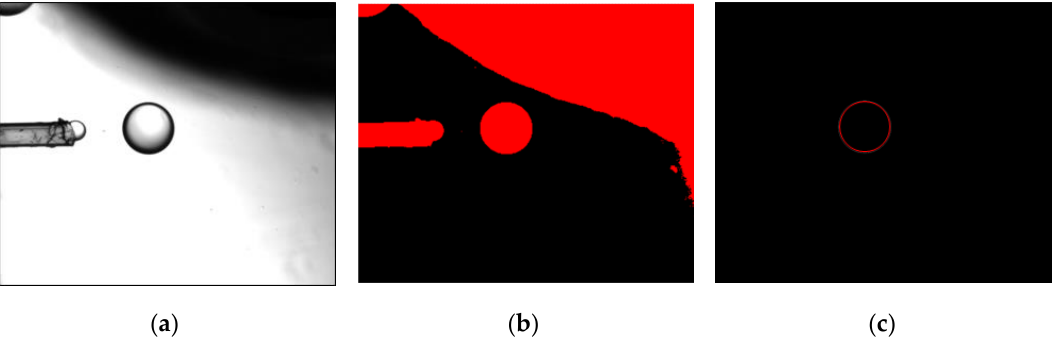
Figure 4. Example for the image processing procedure with a raw image ( a ), binary image with filled holes ( b ) and detected circles in the binary image ( c ).